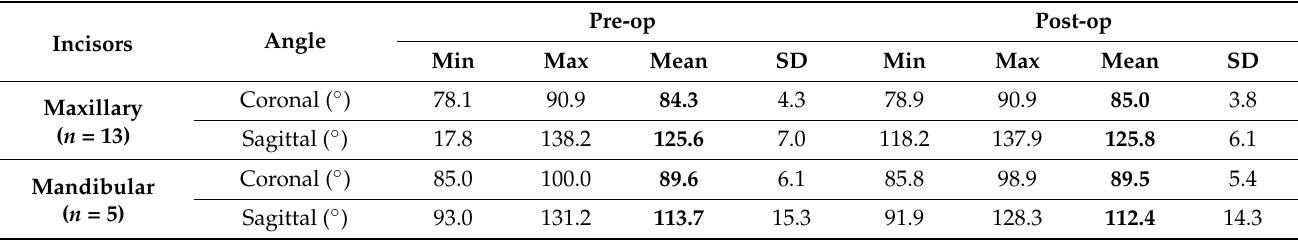
Table 3. Measurements to evaluate accuracy in combining .stl and DICOM